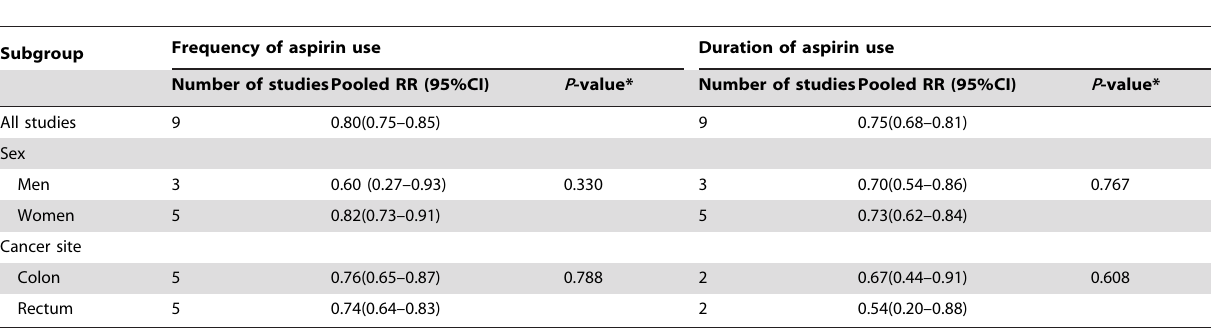
Table 4. Summary of pooled RRs of colorectal cancer by sex and cancer